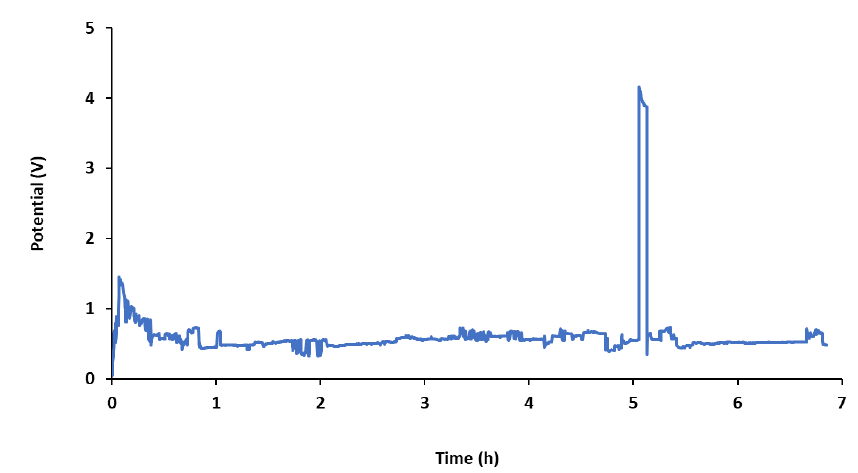
Figure 3. Example of the cell potential trend recorded during a galvanostatic run performed under irradiation and at 0.5 mA: the figure shows the step of potential measured when dark was suddenly made during the run.